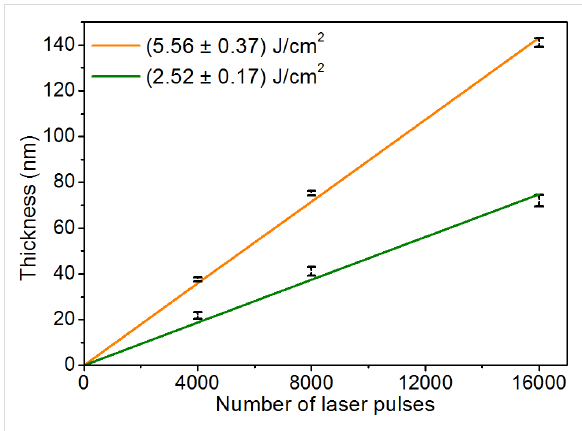
Figure 1: Thickness of the silver nanoisland films as a function of the number of applied laser pulses. Results obtained based on the AFM measurements of the reference samples prepared for laser fluences of 5.56 ± 0.37 J/cm 2 and 2.52 ± 0.17 J/cm 2